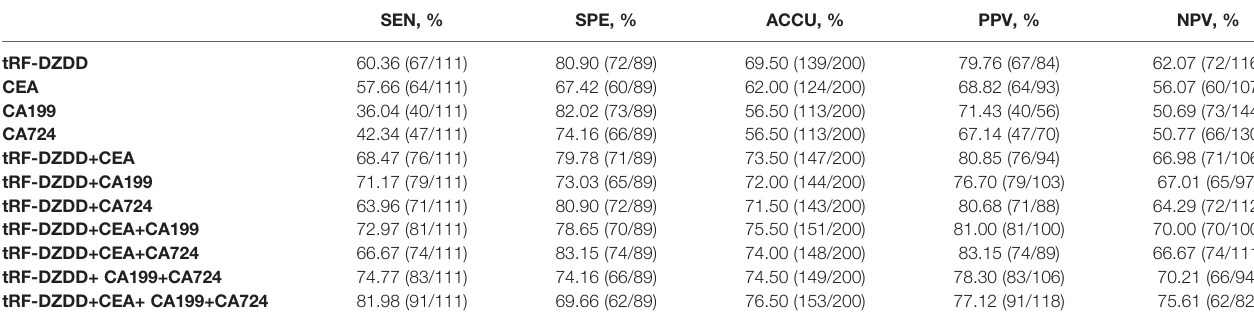
SEN, sensitivity; SPE, speci fi city; ACCU, overall accuracy; PPV, positive predictive value; NPV, negative predictive value.